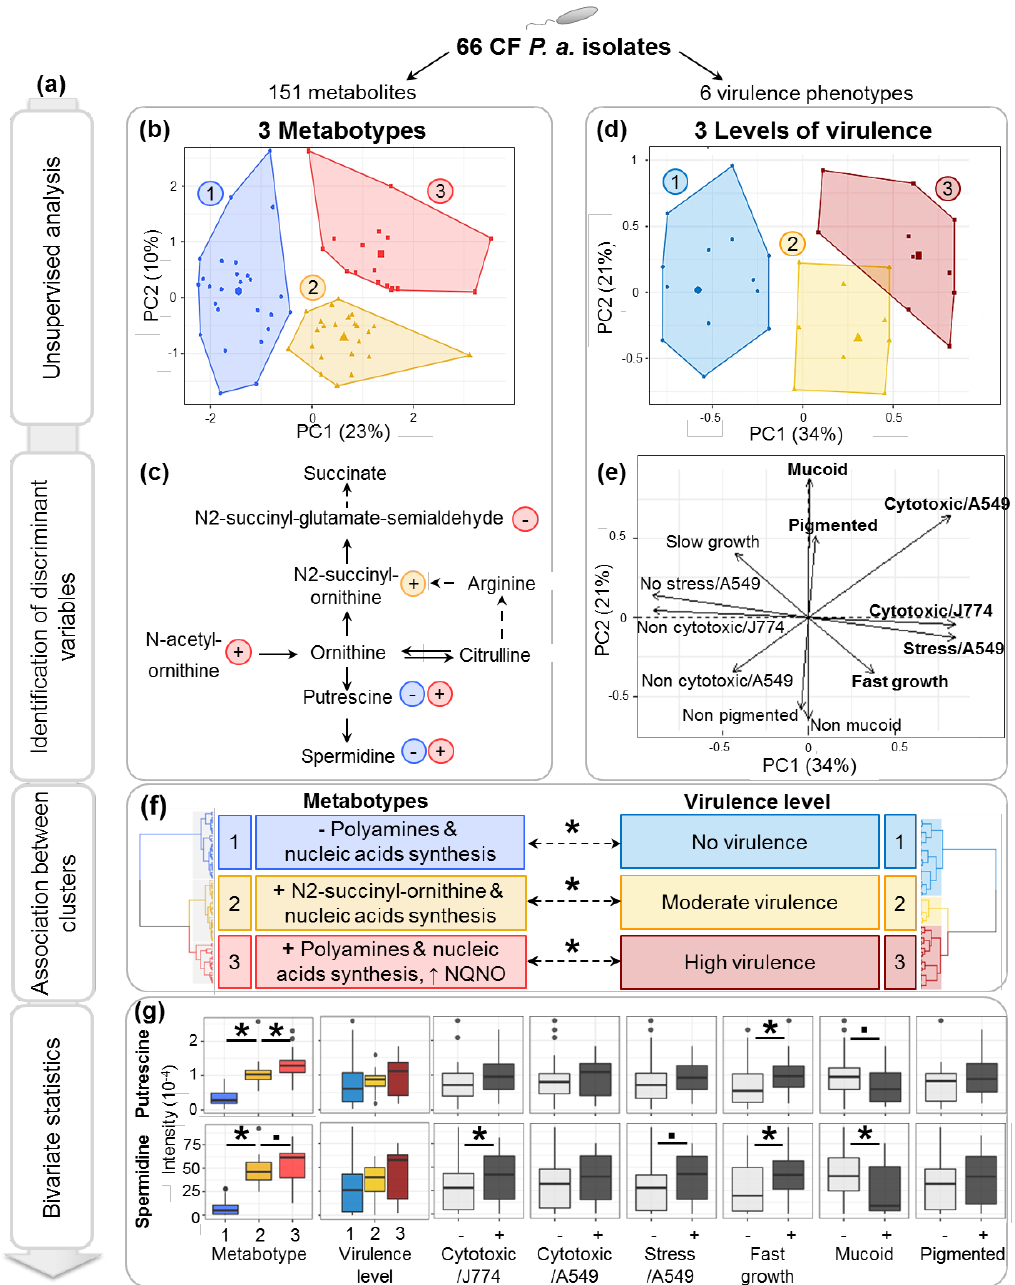
Figure 3. Multiscale analysis identified associations between P.a metabotypes and expression of virulence phenotypes. ( a ) Summary of multiscale statistical workflow. ( b ) Representation of 3 HCPC clusters of isolates expressing similar metabolic profiles (metabotypes) in the first 2 PCs of the MFA. Cluster centroids are shown as larger dots. ( c ) Simplified view of the polyamines (putrescine, spermidine) synthesis pathway (adapted from [35]). Significant metabolites are highlighted by arrows, indicating whether the metabolite is found in higher or lower abundance in the color-matching metabotype. ( d ) Representation of 3 HCPC clusters of isolates expressing similar virulence phenotypes in the first 2 PCs of Multiple Correspondence Analysis (MCA). Clusters centroids are shown as larger dots. ( e ) Representation of the virulence categories in the first 2 PCs of the MCA. ( f ) Dendrograms and summary of the main characteristics of HCPC clusters identified on each data block and associations between P.a virulence level and metabotype (Fisher test p -values <0.05 are indicated by (*)). ( g ) Boxplots showing bivariate relationships between putrescine and spermidine levels with the expression of individual virulence factors (Student t test p -values <0.1 and <0.05 are indicated by (.) and (*), respectively).